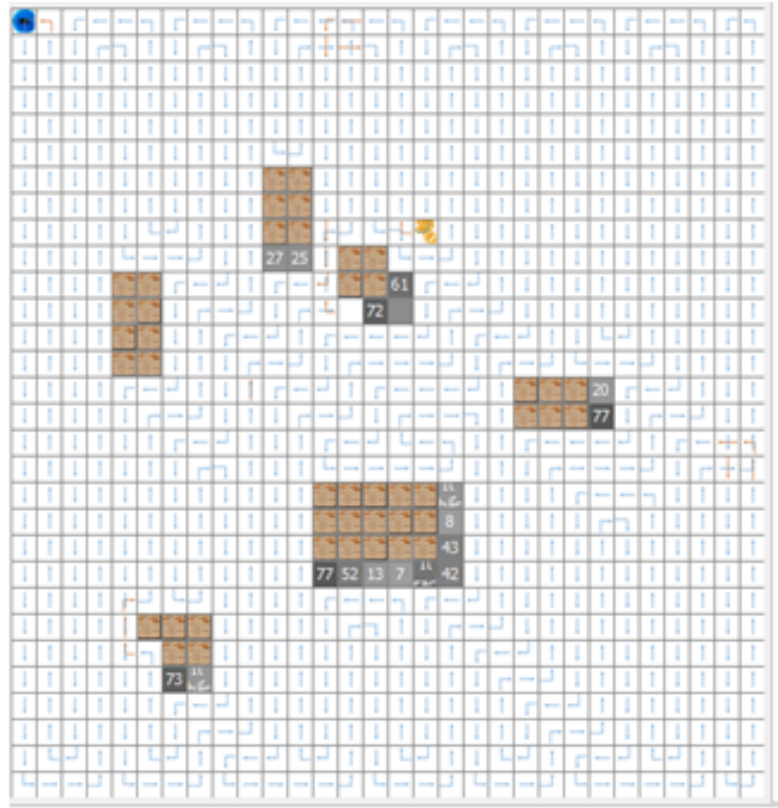
Figure 6. The Cleaning robot operating in heavy cleaning mode.